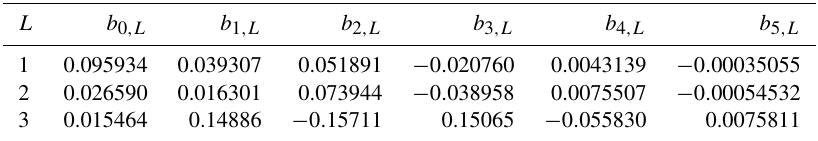
Table A1. Polynomial coefficients relating k to the square root of pigment in depth range L . L b 0 ,L b 1 ,L